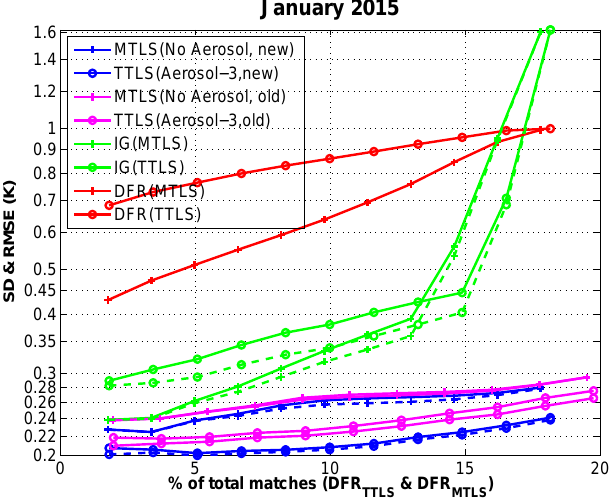
Figure 3. Plots of retrievals for MTLS without aerosol using two retrieved parameters and TTLS with aerosol using three retrieved parameters under DFR ttls and DFR mtls for new and old thresholds of EXF (Experimental